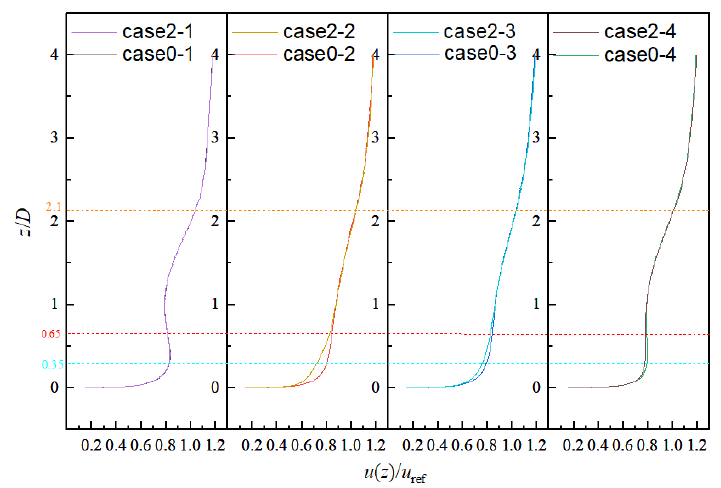
Figure 5. Comparison of vertical velocity wind profiles of Case 2 and Case 0.